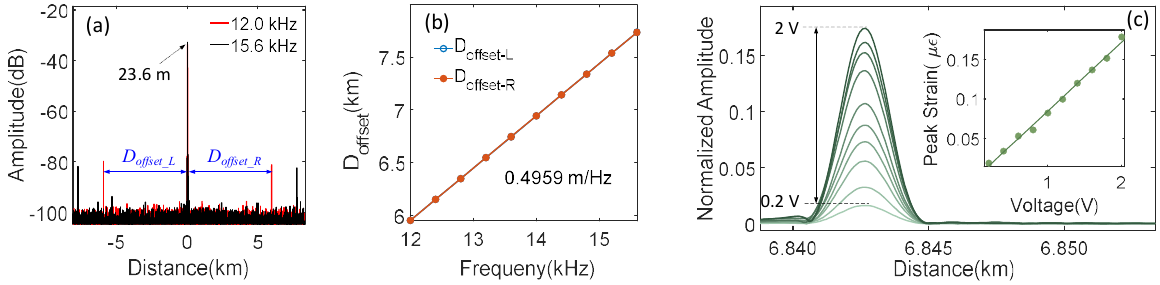
Figure 3. ( a ) Time-domain signals when 12 kHz and 15.6 kHz acoustic signal are generated by the PCC. ( b ) The offset between the main lobe and sidelobes as a function of acoustic frequency. ( c ) Right sideband of the first-order harmonic at the different driving voltages for acoustic frequency of 13.75 kHz. Inset: Peak strain as a function of the driving voltage.